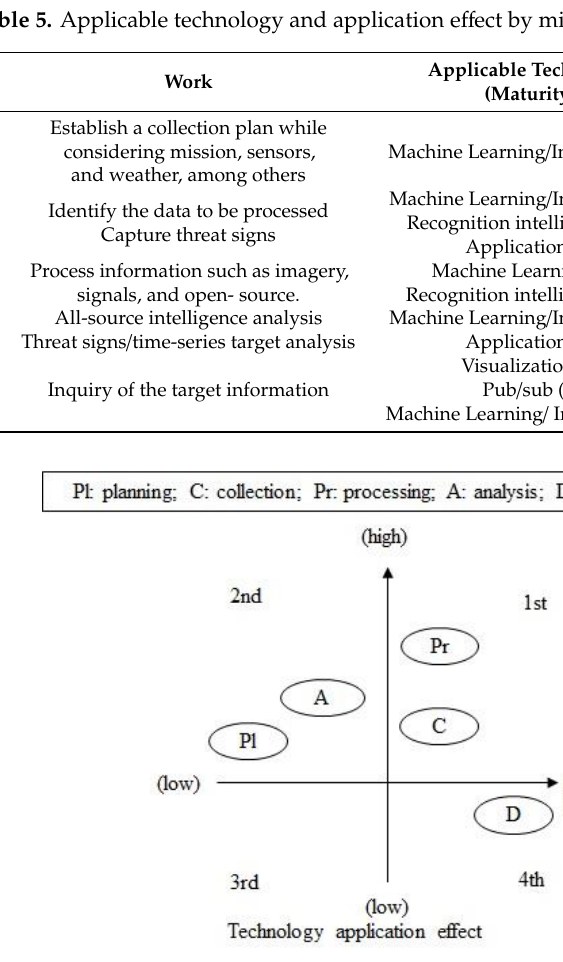
Figure 5. Technology maturity and application effect.